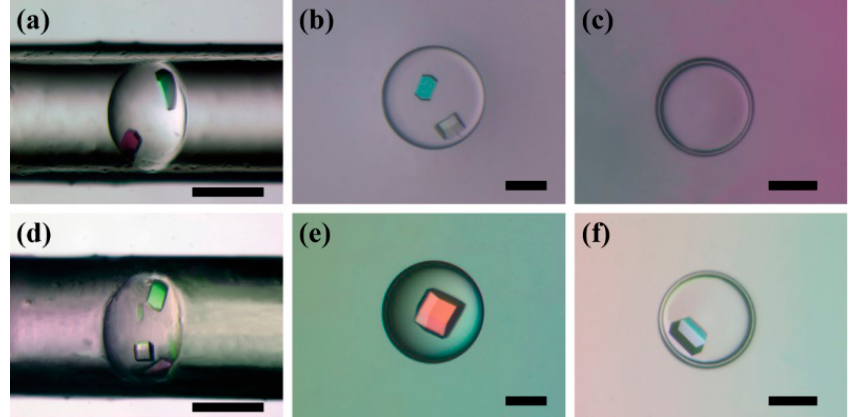
Figure 7. Crystallization results of lysozyme in plugs ( a , d ), droplets ( b , e ) and double emulsions ( c , f ). The oil phases are silicone oil with 3% ( w / w ) 749 Fluid in (a–c) and Al’s oil with 2% ( w / w ) ABIL EM 90 in (d–f). Scale bars: 200 μm.